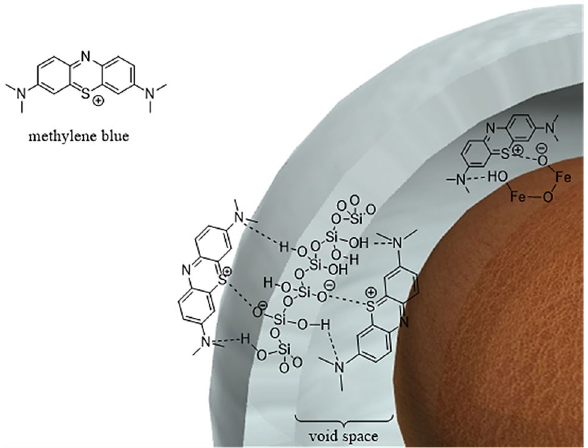
Figure 13. A suitable mechanism for MB adsorption using Fe 3 O 4 @Void@m.SiO 2 .